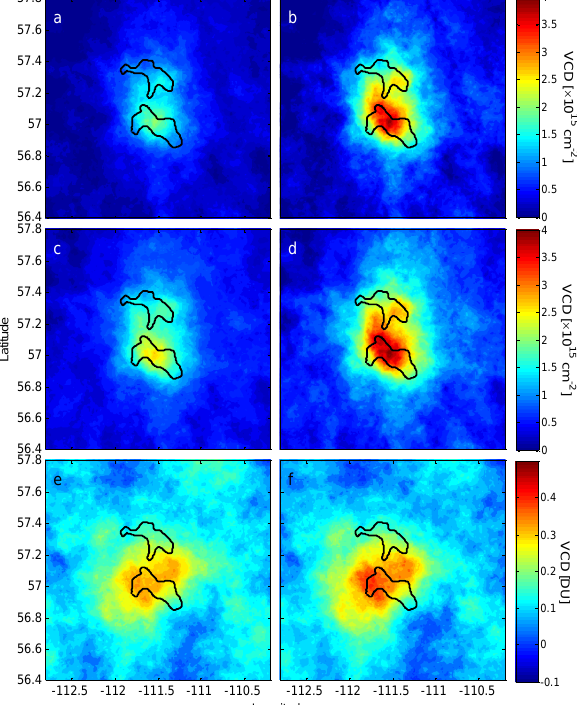
Fig. 8. Average (2005–2011) tropospheric VCDs: (a) DOMINO v2 Figure 8. Average (2005-2011) tropospheric VCDs: (a) DOMINO v2 NO 2 , (b) EC NO 2 NO 2 , (b) EC NO 2 (from DOMINO), (c) SP v2 NO 2 , (d) EC NO 2 (from DOMINO) (c) SP v2 NO 2 , (d) EC NO 2 (from SP), (e) NASA SO 2 , (f) EC SO 2 . (from SP), (e) NASA SO 2 , and (f) EC SO 2